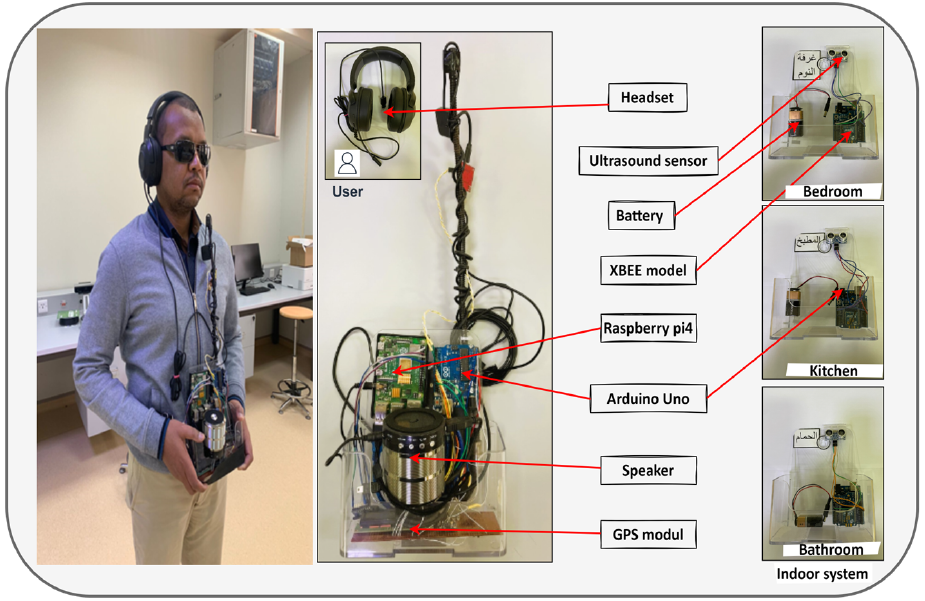
Figure 2. Prototype of the wearable smart system.